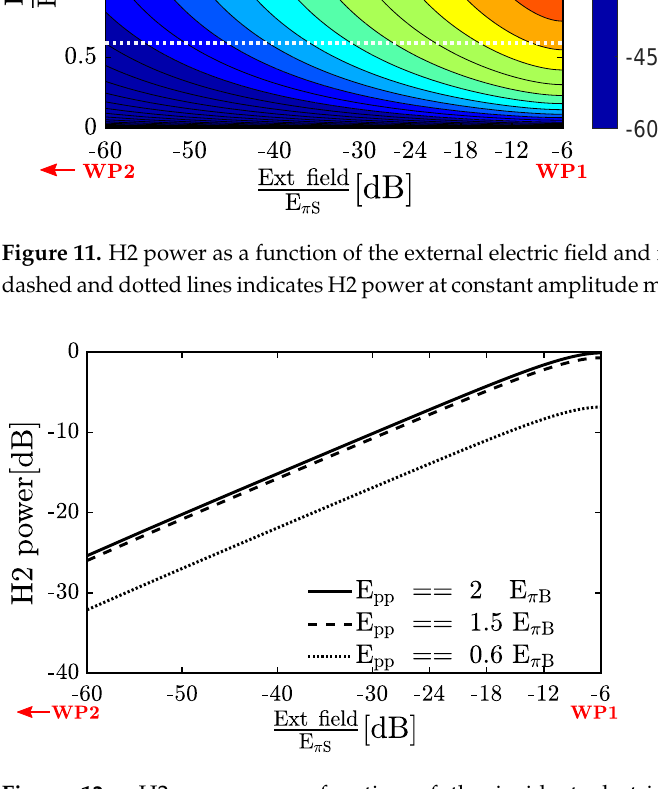
Figure 12. H2 power as a function of the incident electric field for fixed values of the modulation